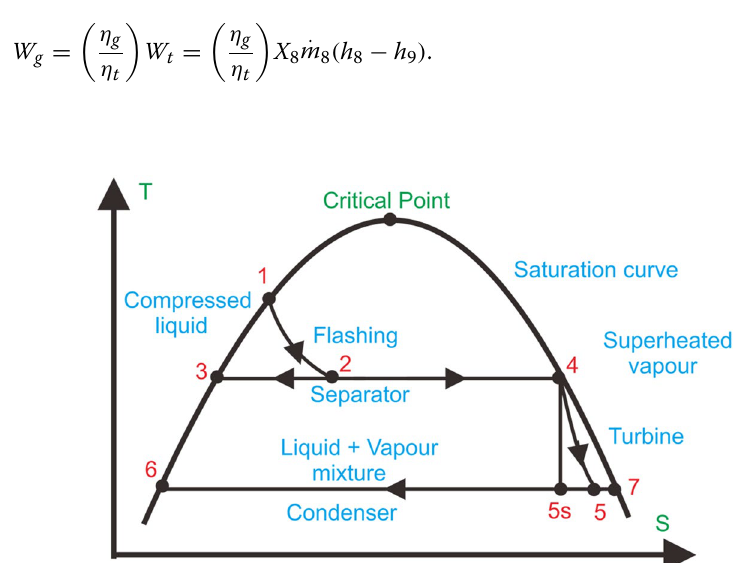
Fig. 6 The turbine expansion flow process. Steam from the demister (state 7) is used for the turbine and the steam ejectors of the first (state 11) second (state 10)